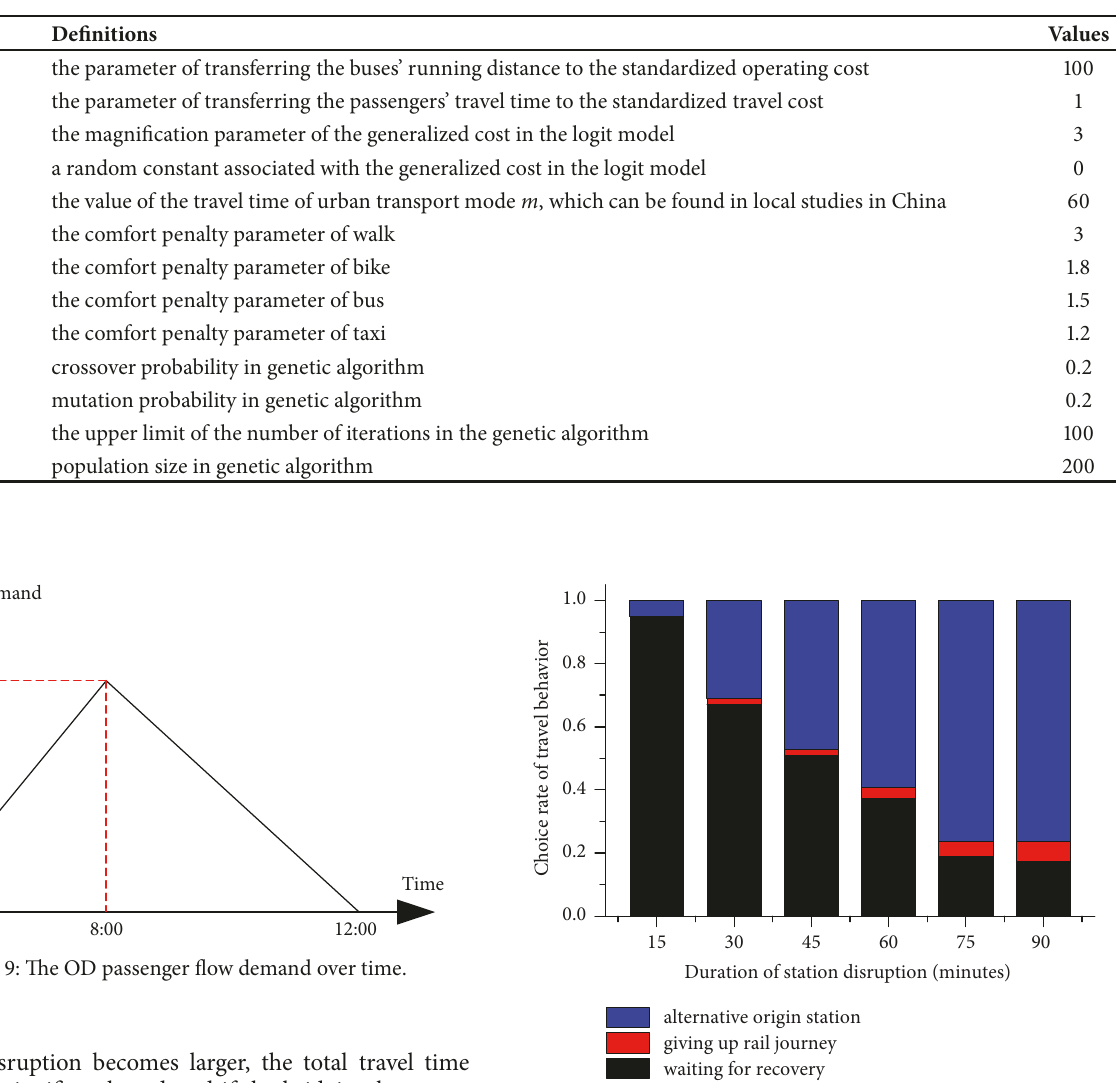
Table 2: Values of some parameters in the numerical study.